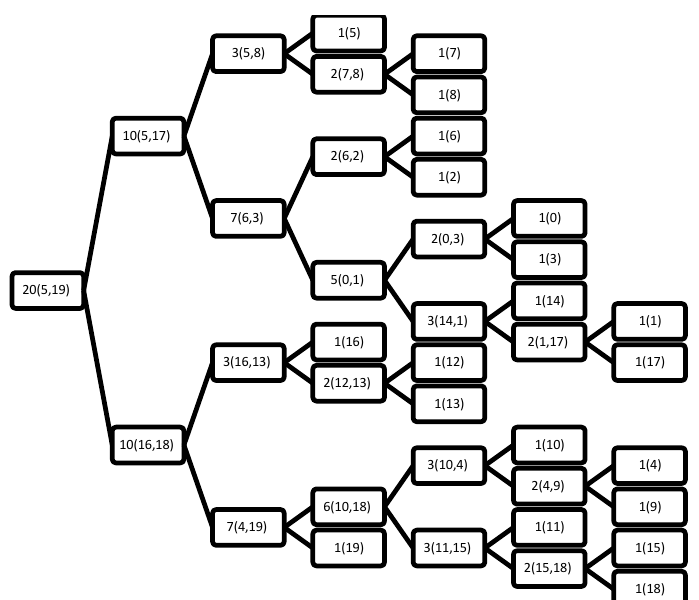
Figure 2. The resultant BST after applying the training phase of the FPBST on the sample data from Table 1. The number outside the brackets is the counter of the examples hosted by each node, and those inside the brackets are the index of the examples in a leaf node, or the furthest points (P1 and P2) otherwise.